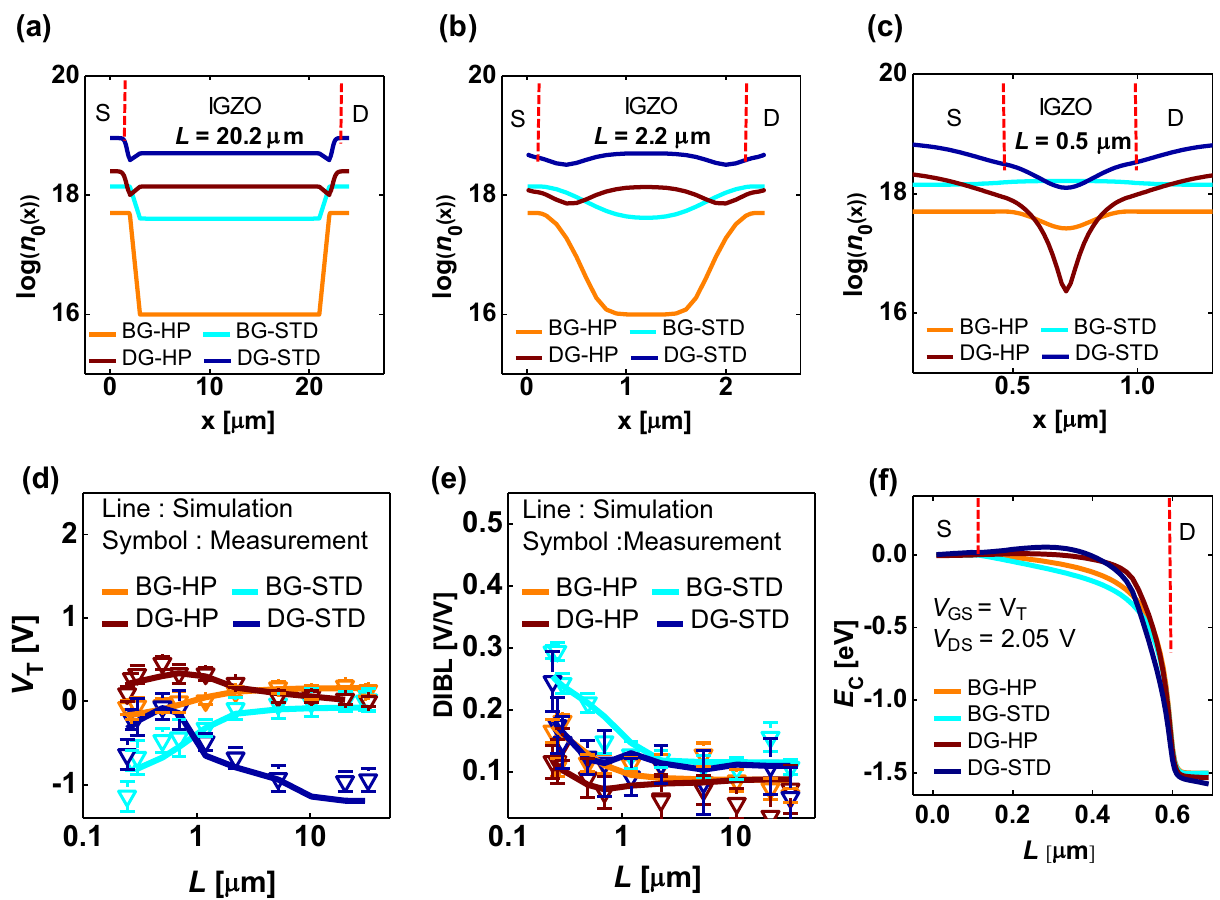
Figure 8. The TCAD-simulated n 0 ( x ) profiles in the four types of samples along the structures and processes with varying channel length. ( a ) L = 20.2 μm, ( b ) L = 2.2 μm, and ( c ) L = 0.5 μm. The TCAD simulated (line) vs. the measured (symbol) L -dependent ( d ) V T and ( e ) DIBL. Error bar was taken from six device samples. ( f ) The energy band obtained through the TCAD simulation for the BG-HP, BG-STD, DG-HP, and DG-STD devices at W/L = 0.5/1